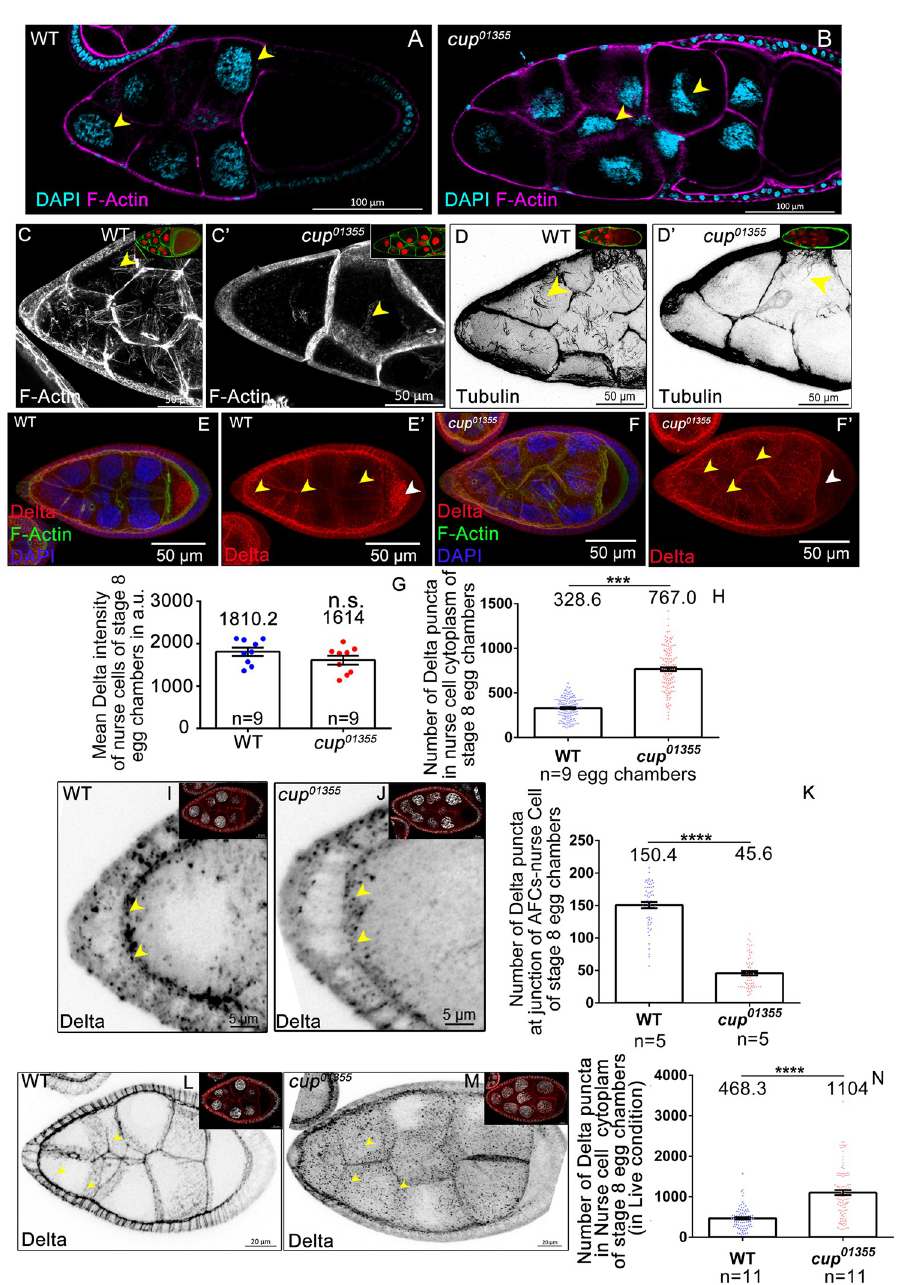
Fig 4. Cup modulates nurse cell cytoskeleton and Delta trafficking. (A-B) Nurse cell nuclear morphology is disrupted in cup 01355 egg chambers. Nuclei (yellow arrow heads) are elongated and mispositioned in cup 01355 egg chambers compared to round nuclei observed in wild type, F-actin (Magenta), DAPI (cyan). (C-C’) Phalloidin staining of cup 01355 egg chambers exhibit reduced actin fibers (yellow arrow heads) compared to wild type egg, F-actin (grey, green in inset), DAPI (red). (D-D’) Tubulin stained cup 01355 egg chambers show smaller, randomly distributed tubulin fibres (yellow arrow heads) in nurse cell cytoplasm compared to distinct radially arranged fibers observed in the wild type, tubulin (black, green in inset), DAPI (red). (E-H) Delta stained cup 01355 egg chambers exhibit more cytoplasmic puncta in nurse cells as compared to wild type (yellow arrows). Oocyte Delta localisation is absent in cup 01355 egg chambers as observed in the wild type (white arrow head). Delta (red), F-actin (green), DAPI (blue). Mean Delta intensity of wild type and cup 01355 egg chambers is similar (G). However, the number of cytoplasmic puncta in the cup 01355 nurse cells is higher than that observed in the wild type (H) . (I-J) Stage 8 egg chamber of indicated genotypes stained for Delta (black) (yellow arrowhead). Inset is the representative egg chamber. (K) Quantification of Delta puncta at the junction of nurse cell and anterior follicle cell suggest that Delta trafficking is perturbed in the